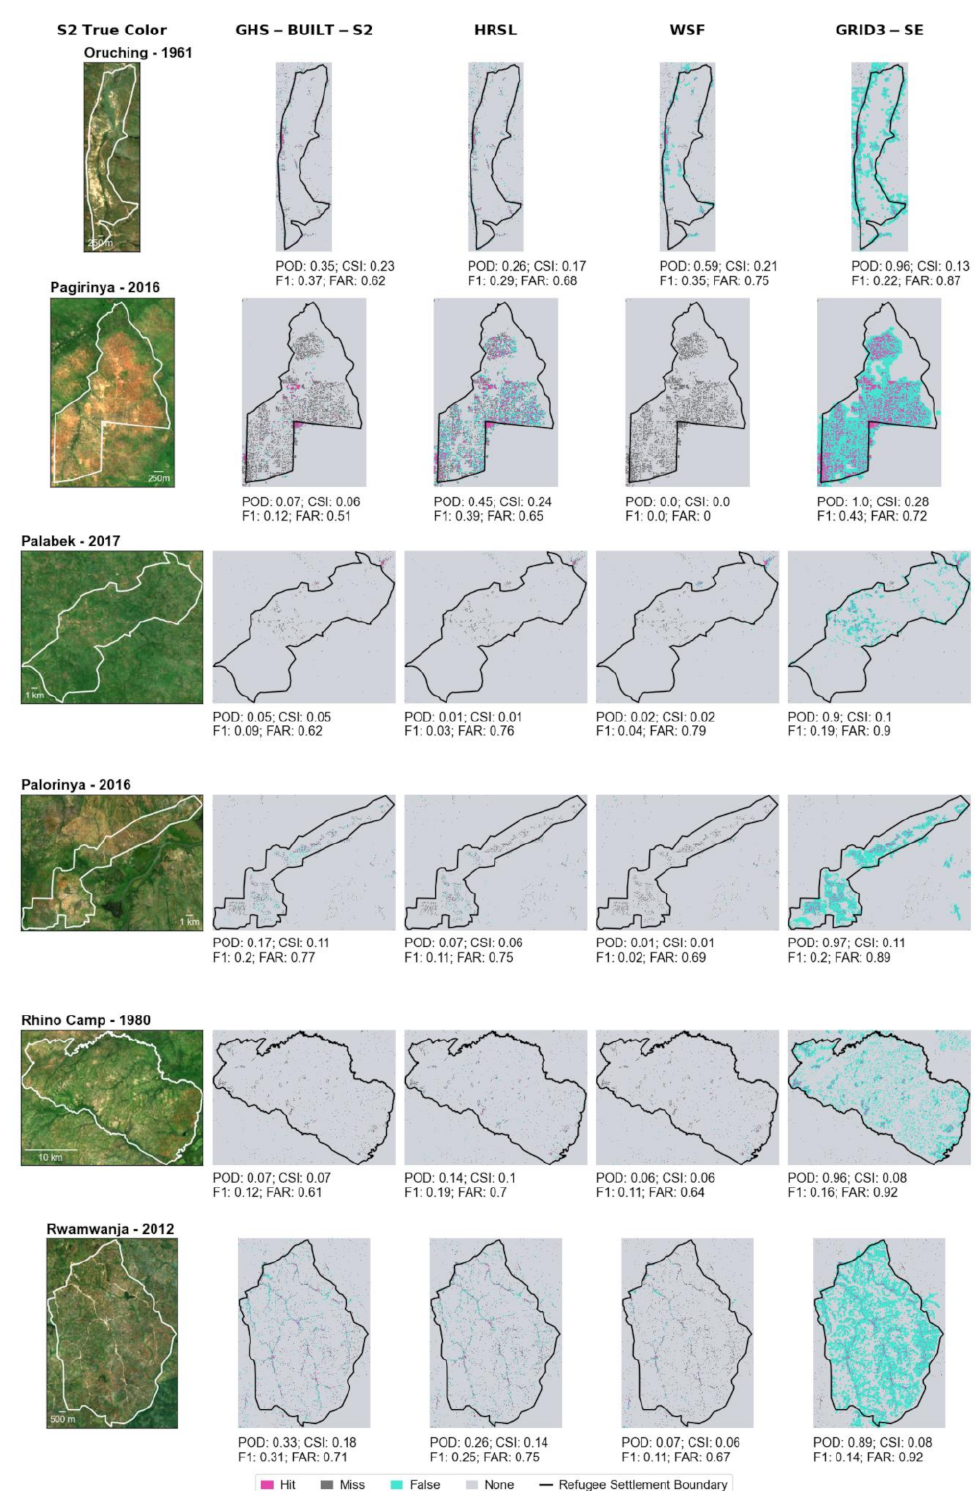
Figure A2. Settlement-level maps and detection metrics for the four settlement products. Detection metrics are evaluated relative to OSM–MS building footprint coverage within settlement boundaries. Background images based on Sentinel-2 (S2) true-color imagery from August 2019. GHS-BUILT-S2, Global Human Settlement Layer with Sentinel 2; HRSL, High Resolution Settlement Layer; WSF, World Settlement Footprint; GRID3-SE, Geo-Referenced Infrastructure and Demographic Data for Development settlement extent data; POD, probability of detection; CSI, critical success index; F1, F1-score; FAR, false alarm